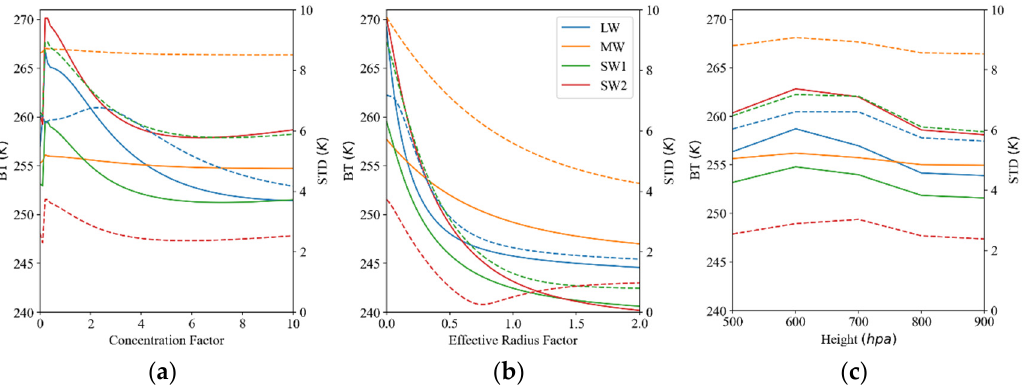
Figure 6. Variation in the mean (solid line) and standard deviation (dashed line) of the simulated brightness temperatures with an aerosol concentration scaling factor ( a ), effective radius scaling factor ( b ), and layer height ( c ) for the four dust-sensitive bands, respectively (LW: 750~1090 cm − 1 ; MW:1210~1350 cm -1 ; SW1:2155~2230 cm -1 ; SW2:2390~2550 cm -1 ).